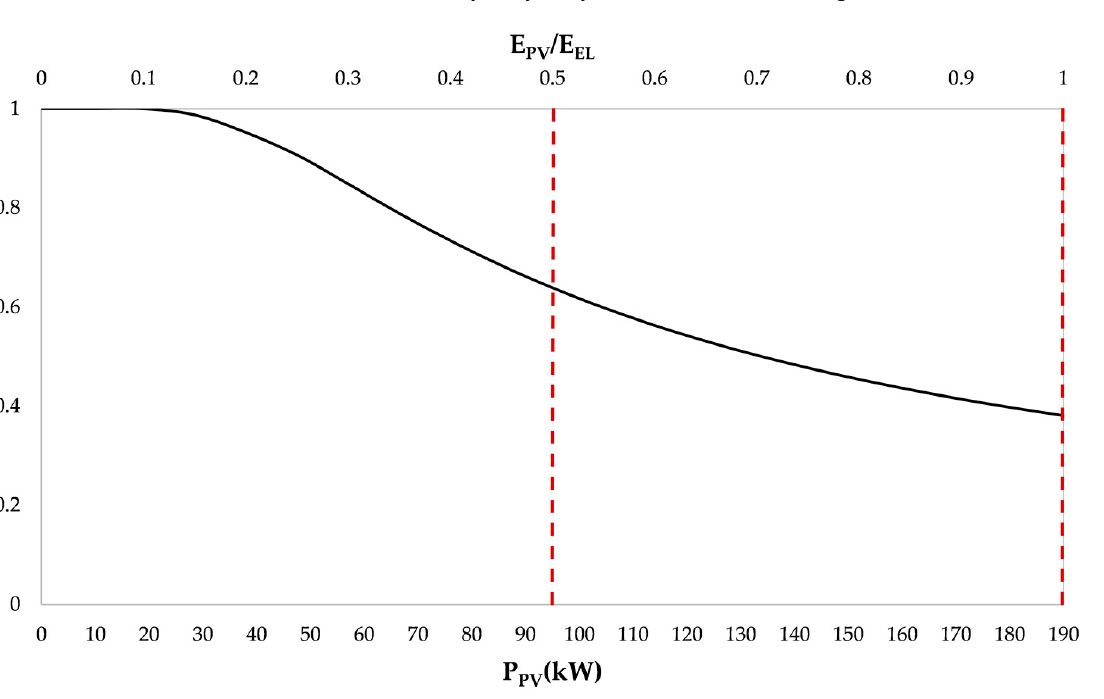
Figure 2. SCR versus the PV peak power and the ratio between the energy produced by the PV system and the electricity demand of the community on yearly basis.